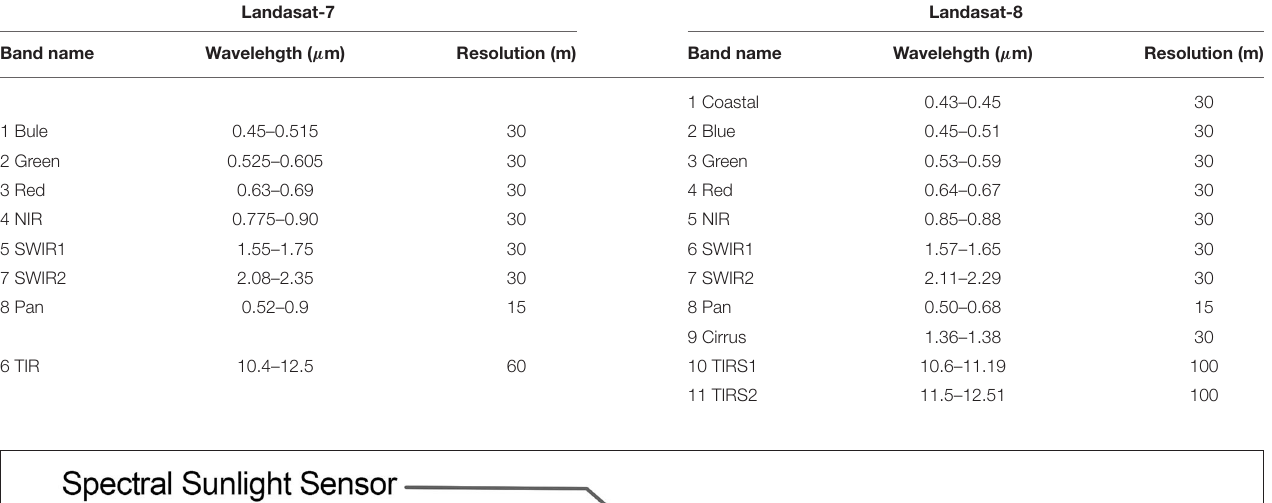
TABLE 1 | Specifications of Landsat-7 and Landsat-8.